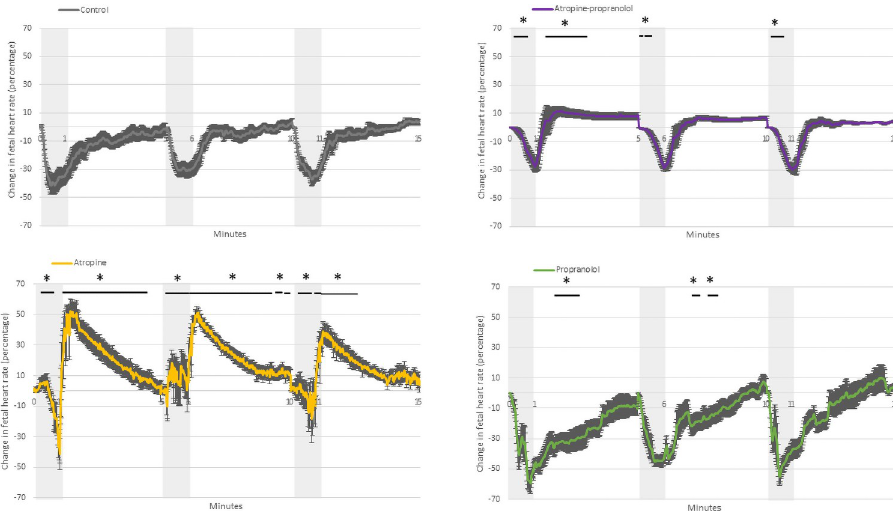
Fig 3. Fetal mean arterial pressure. Fetal mean arterial pressure in control, atropine, propranolol and atropine- propranolol protocols in fetuses exposed to three applications of 1-minute umbilical cord occlusion (grey zone) every 5 minutes. Data are expressed as mean ± standard error. � p < 0.05 vs. control. Resolution of each datapoint: 1 second.